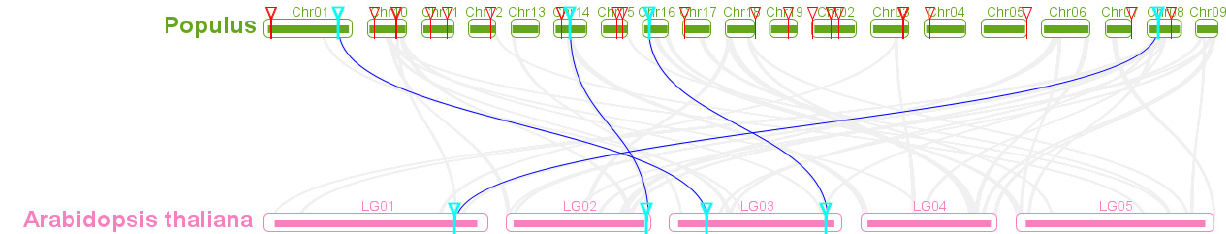
Figure 5. Homology analysis of poplar and Arabidopsis SBP genes. The gray line represents the collinear block of poplar and Arabidopsis genomes, the blue line represents the SBP orthologous pair, the red triangle represents the poplar SBP gene and the blue triangle represents the orthologous gene of two species.